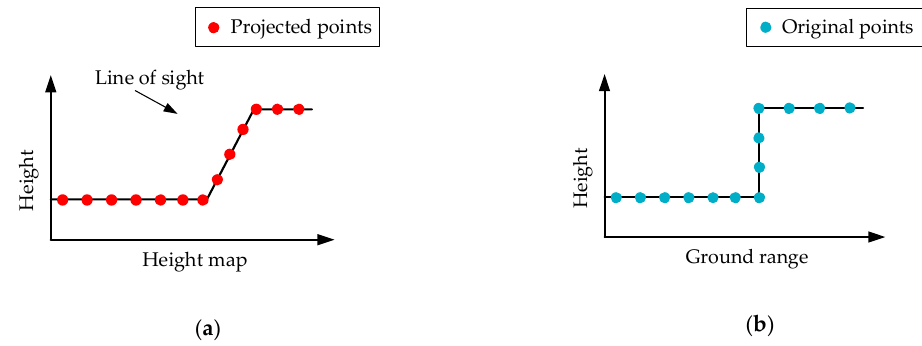
Figure 7. Schematic geometry of the building structure. ( a ) Rectified building shape in the height map. ( b ) Original building shape in the ground range.